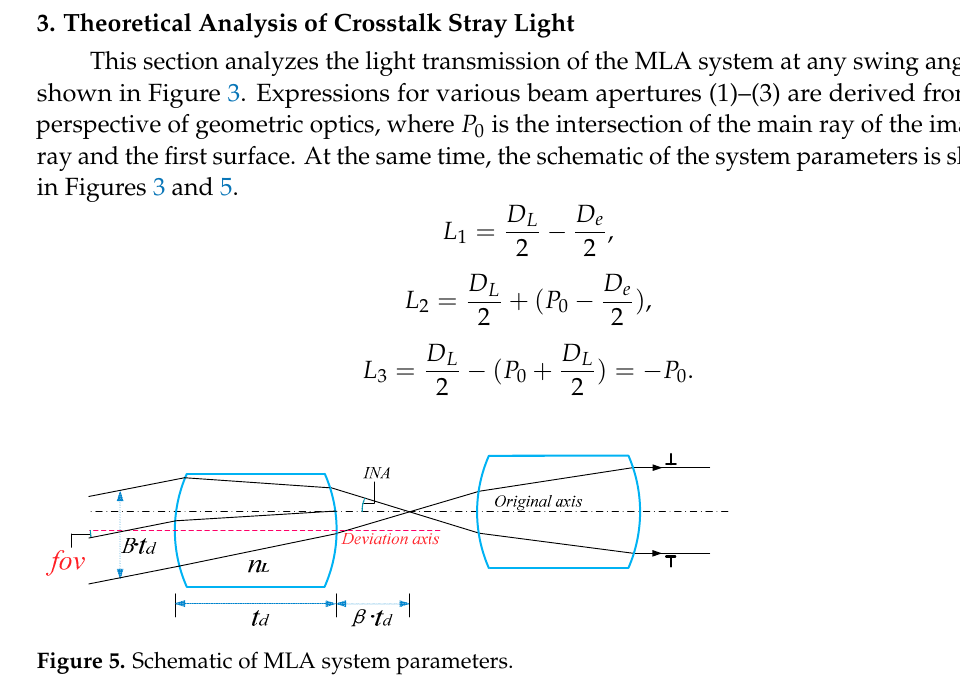
Figure 4. Schematic of the MLA system at the maximum swing angle.